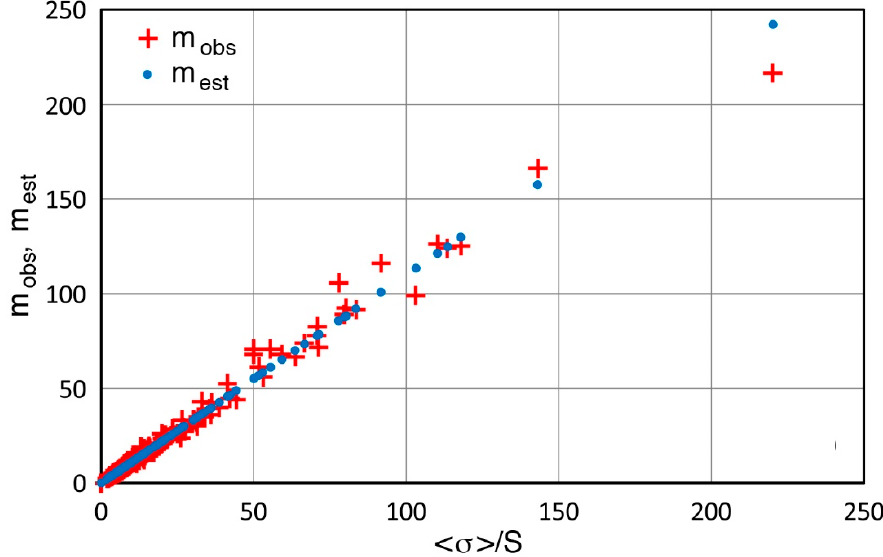
Figure 2. Plots of m obs (red + symbol) and m est (blue dot) vs. < σ >/ S for the whole datasets.